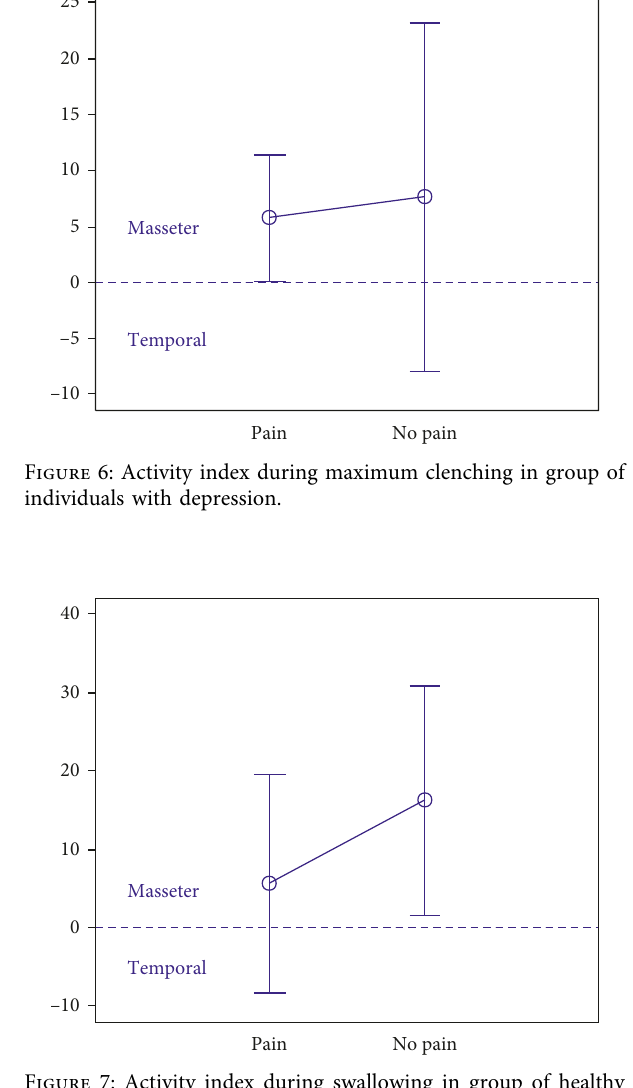
Figure 5: Activity index during maximum clenching in group of TMD individuals.